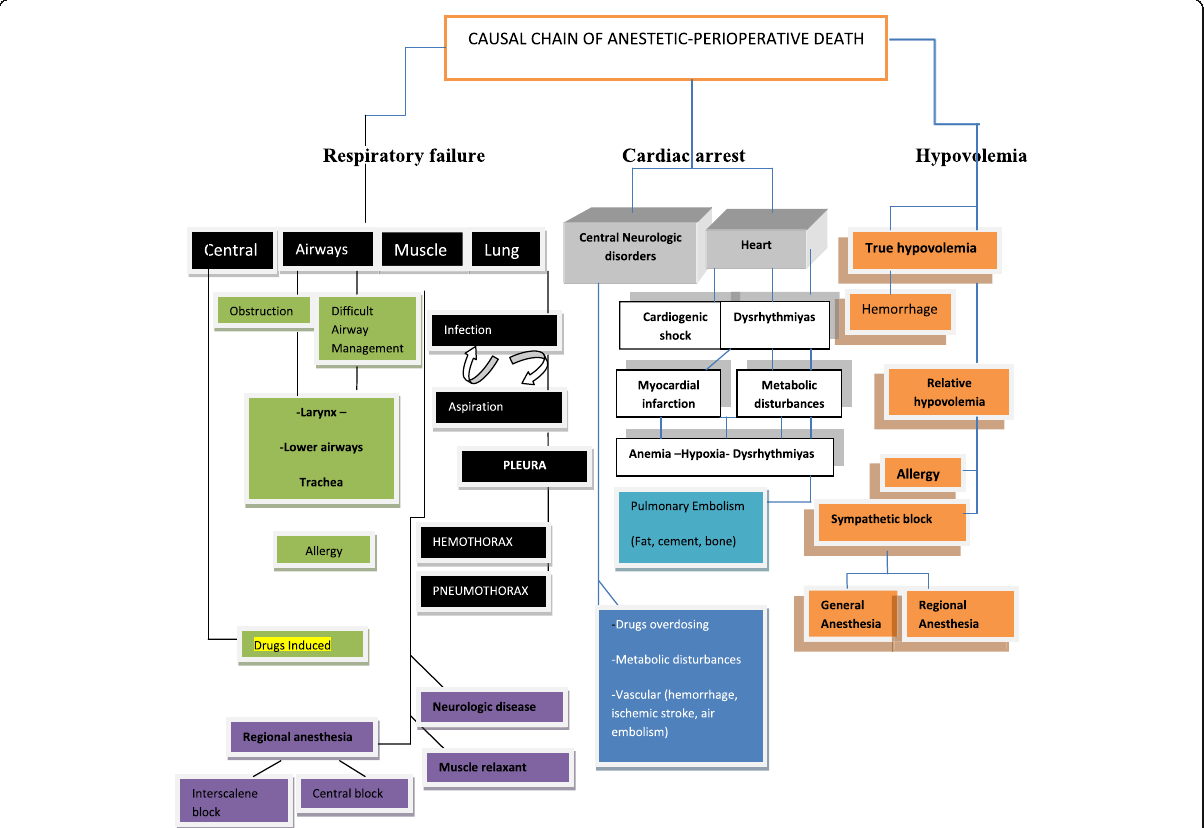
Fig. 1 Description of causal and consequences related to anesthetic-perioperative death. Legend: Summarizes common aspects of interest regarding pathology in AAD and